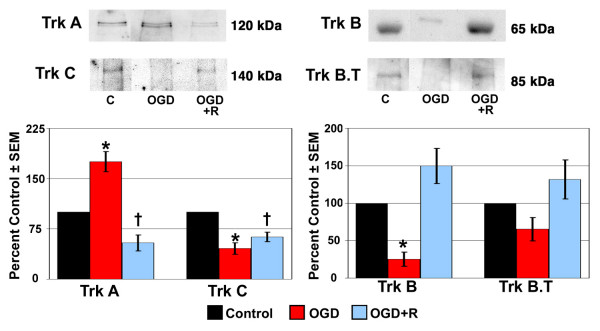
Trk receptor protein expression in LC cells following exposure to and recovery from Oxygen-Glucose Deprivation. Lamina cribrosa cells were exposed to OGD for 48 hours (OGD) or to 48 hours OGD followed by recovery for 24 hours (OGD+R). Cells exposed to growth media and 95% air/5% CO2 for 48 hours served as controls (C). Cell lysate was separated by SDS-PAGE and the density of unsaturated bands was measured for each blot. A representative blot for each Trk receptor is shown. Band density reported as mean percent of the control ± SEM (n = 3) is shown graphically beneath the blots. * indicates p < 0.016 for OGD compared to C and OGD+R; † indicates p < 0.016 for OGD+R compared to C (one way analysis of variance [ANOVA] followed by validation using Student-Newman-Keuls tests). Trk B.T; truncated Trk B.